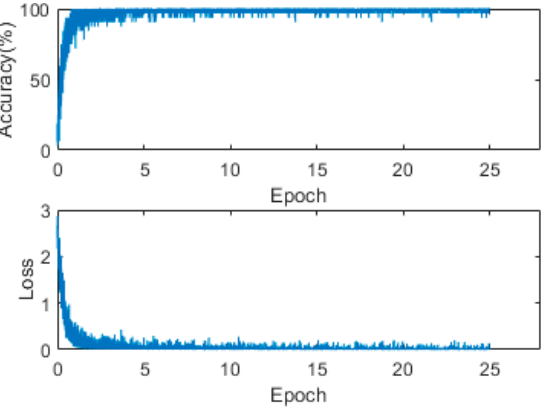
Figure 7. The loss and accuracy curve from the training process.